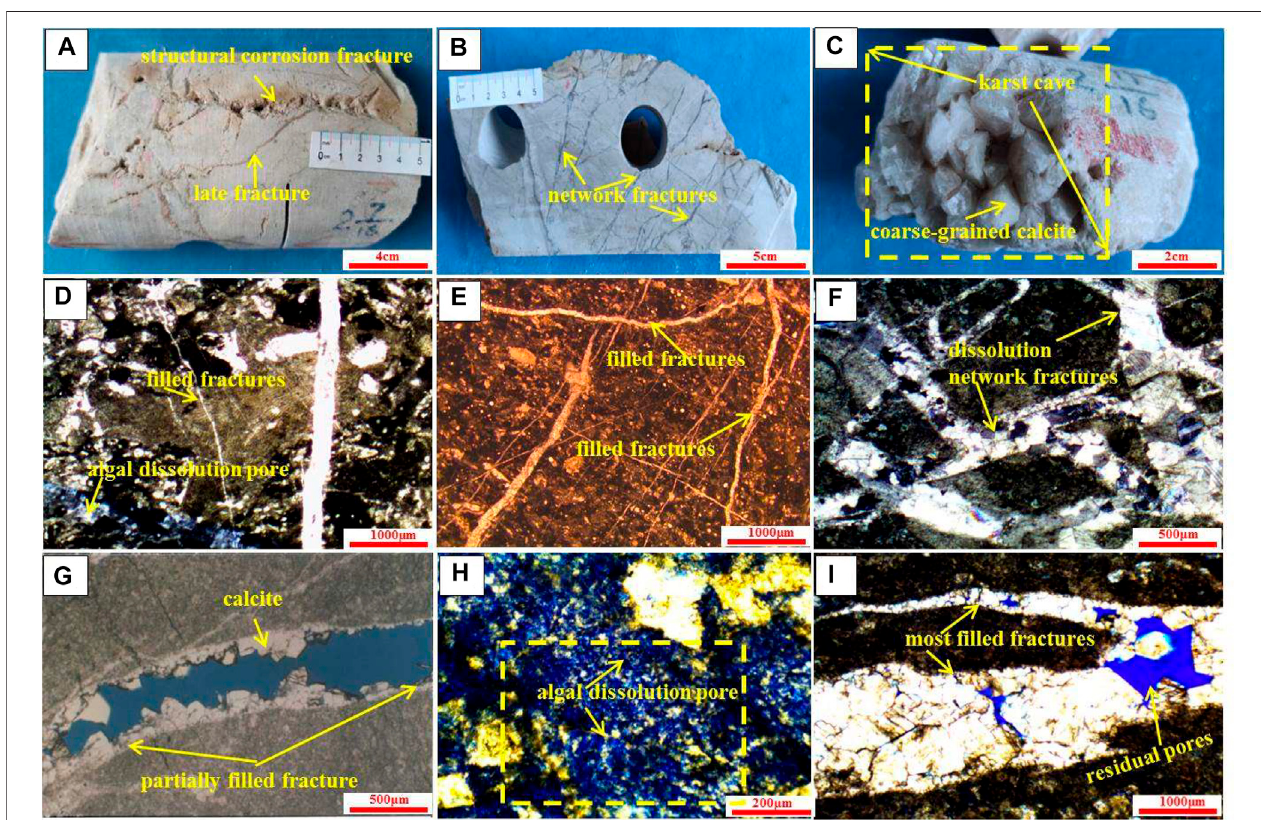
FIGURE 3 | Carbonate reservoir space characteristics in the buried hills of the Weixinan Depression. (A) W1 – N1, 1,553 m, grainy biological limestone, and the tectonic fractures cut and restrict each other. The early fractures are fi lled with medium – coarse calcite, the width of the fractures is 0.4 mm, there are a few dissolution pores along the fractures, and the growth of the late fractures is restricted by the early fractures. (B) W1 – N1, 1,554 m, grain – white biological limestone with reticulated weathering fractures, whichare generally fi lledwith fi ne – grained calcite. (C) W1 – N1, 1,556 m, karst caves fi lled withhorse – tooth – shaped giantcalcite crystals, the karst cave diameter is 6 cm, and light crude oil fl ows out of the core. (D) W1 – N2, 1,587 m, algal limestone, with a tectonic fracture with a width of 160 μ m and several tectonic and weathering fractureswithwidths of less than 10 μ m are all fi lled with sparry calcite. (E) W1 – N3, 1,612 m, bioclasticlimestone,the weathering fracturesand tectonic fractures cut each other, and the fractures are fi lled with sparry calcite. (F) W1 – N3, 1,615 m, bioclastic limestone with obvious recrystallization and dissolved network fractures fi lled with medium – coarse grain calcite with only a few residual pores. (G) W1 – N1, 1,555.65, residual pores in the semi fi lled fractures with good connectivity. (H) W1 – N3, biological algal limestone, local red algae dissolved into pores and relatively developed pores. (I) Well W1 – N1, 1,555.8 m, bioclastic limestone with residual pores in the fractures.